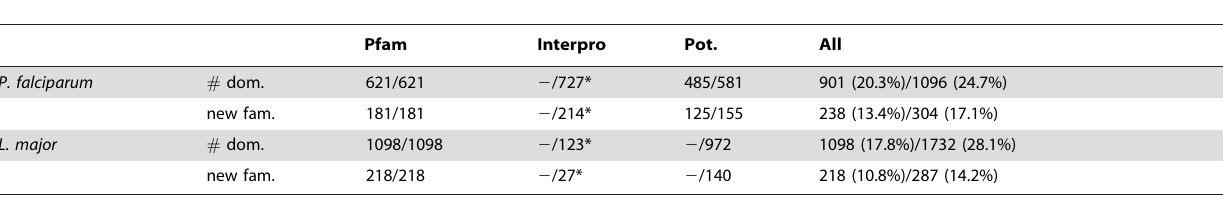
Table 2. New Pfam domains (release 26) identified at 5% and 10% FDR.